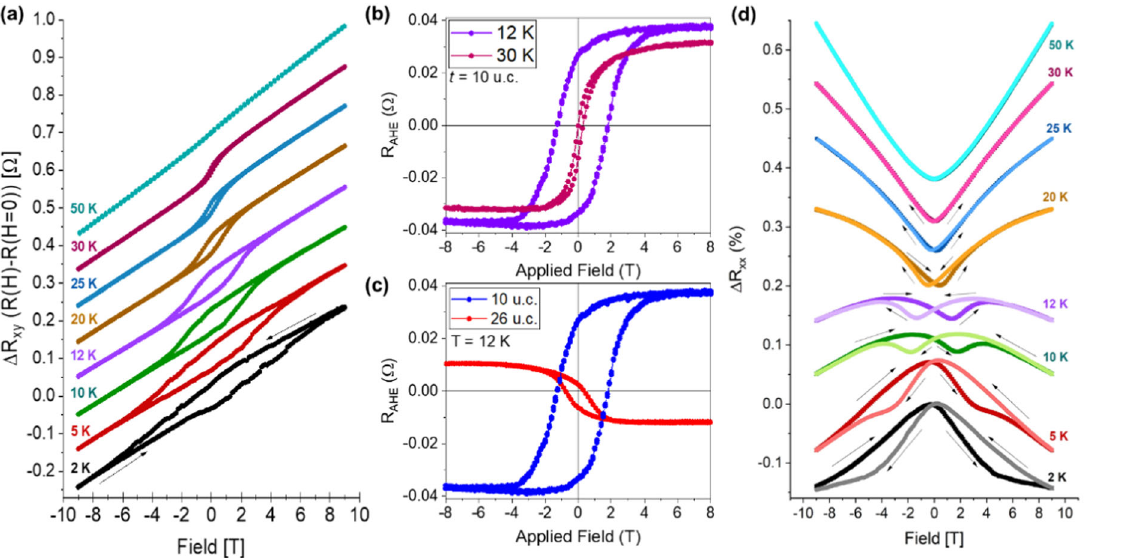
Fig. 4 Field-dependent electronic transport measurements of (111)-oriented LaNiO 3 . a Hall effect results at various temperatures for 10-u. c.-thick LNO(111). Scans are shifted for visibility and arrows indicate the direction of scan, fi eld cooled at H = 9 T, b anomalous Hall effect loops at various T = 12, 30 K, linear ordinary Hall effect has been subtracted, c anomalous Hall effect loops for t = 10, 26 u.c., linear ordinary Hall effect has been subtracted, d magnetoresistance at various temperatures of 10 u.c., (111)-oriented LaNiO 3 , fi eld cooled at H = 9 T. Magnetoresistance ( Δ R xx = ( R ( H ) − R 0 )/ R 0 ) results are shifted for visibility and arrows indicate the direction of